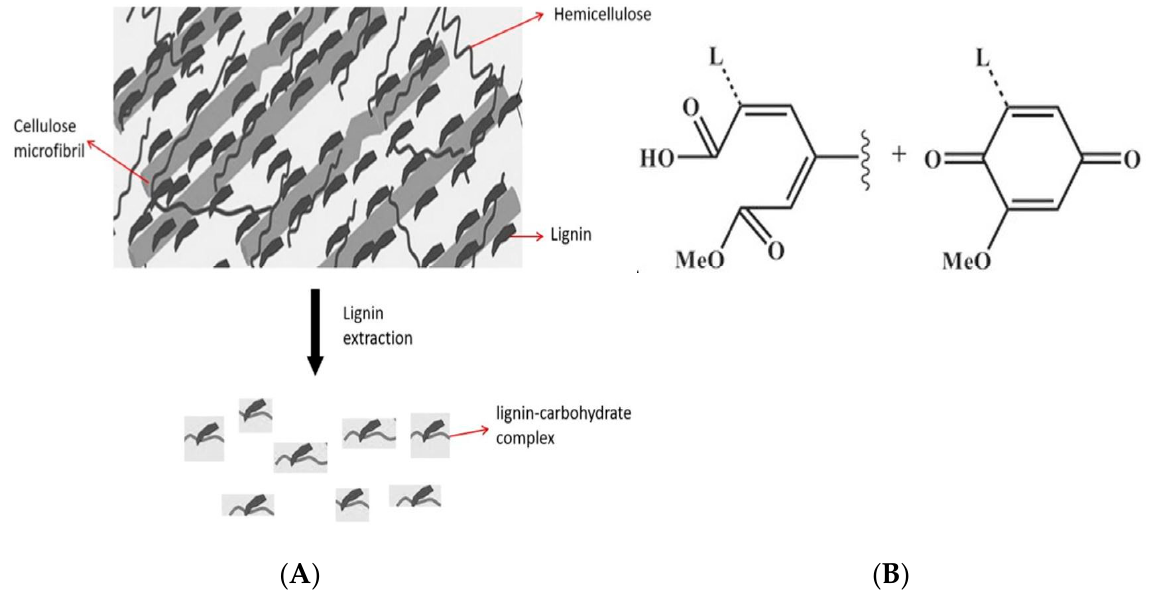
Figure 1. Lignin-carbohydrate complex formation during lignin extraction from a lignocellulosic biomass ( A ). Lignin main fragments obtained from lignocellulosic biomass following NaClO 2 treatment (Li et al. 2017) ( B ).